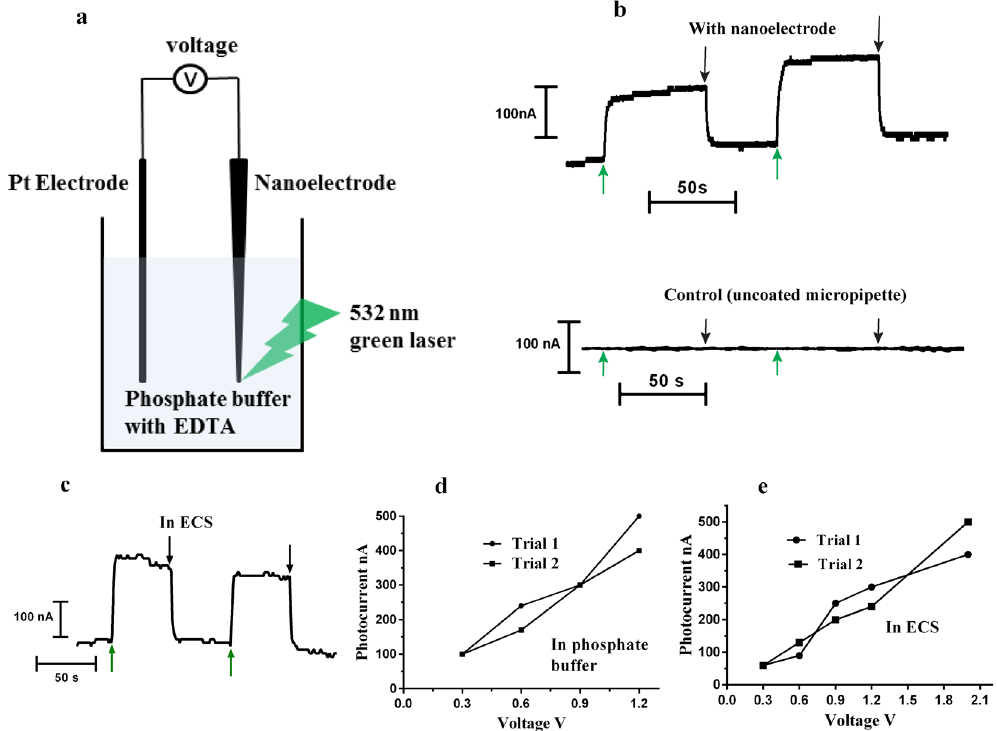
Figure 2. Nanoelectrode testing – Photocurrent measurements. ( a ) Light induced photocurrents were recorded when a nanoeletrode was illuminated with a 532 nm green laser in an electrochemical cell. The experimental set-up schematic is shown in ( a ). A 0.1 M phosphate buffer/0.05 M EDTA solution was used as the electrolyte and standard calomel electrode was used as the reference electrode. ( b ) A 0.3 V vs Ag (s) /AgCl,